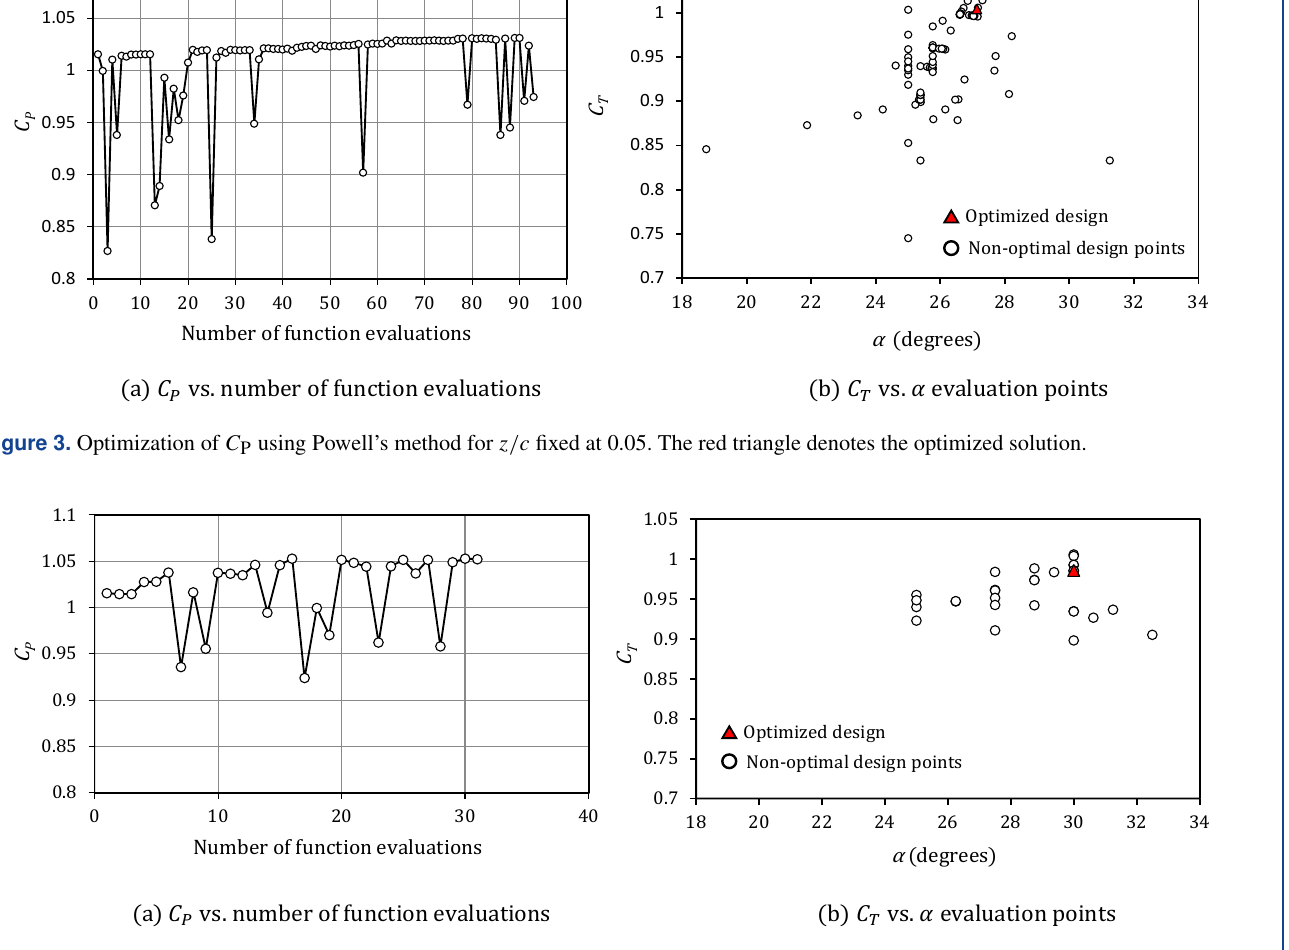
Figure 4. Optimization of C P using Hooke and Jeeves’ method for z/c fixed at 0.05. The red triangle denotes the optimized solution.